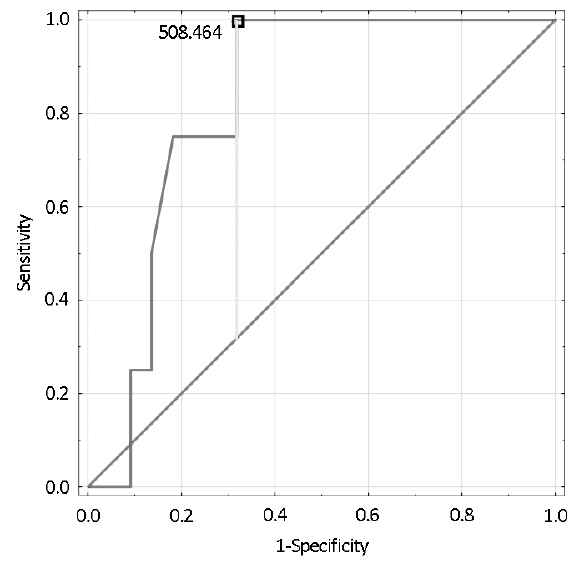
Figure 3. The ROC curve representing efficacy of DDP4 expression before the HSCT in prediction of dyslipidemia after the HSCT.